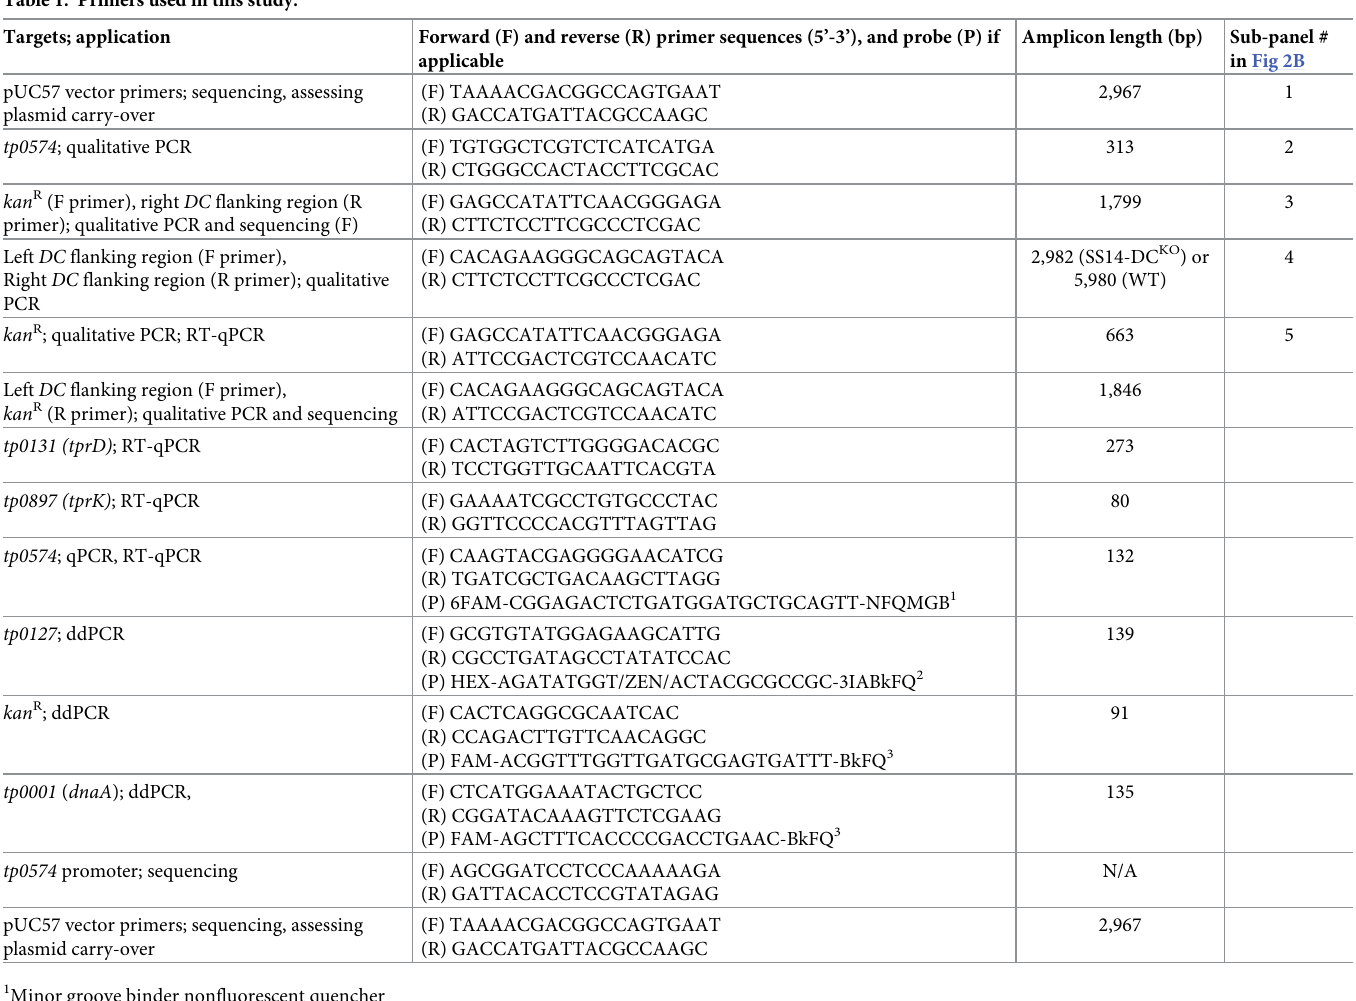
Table 1. Primers used in this study. Targets;